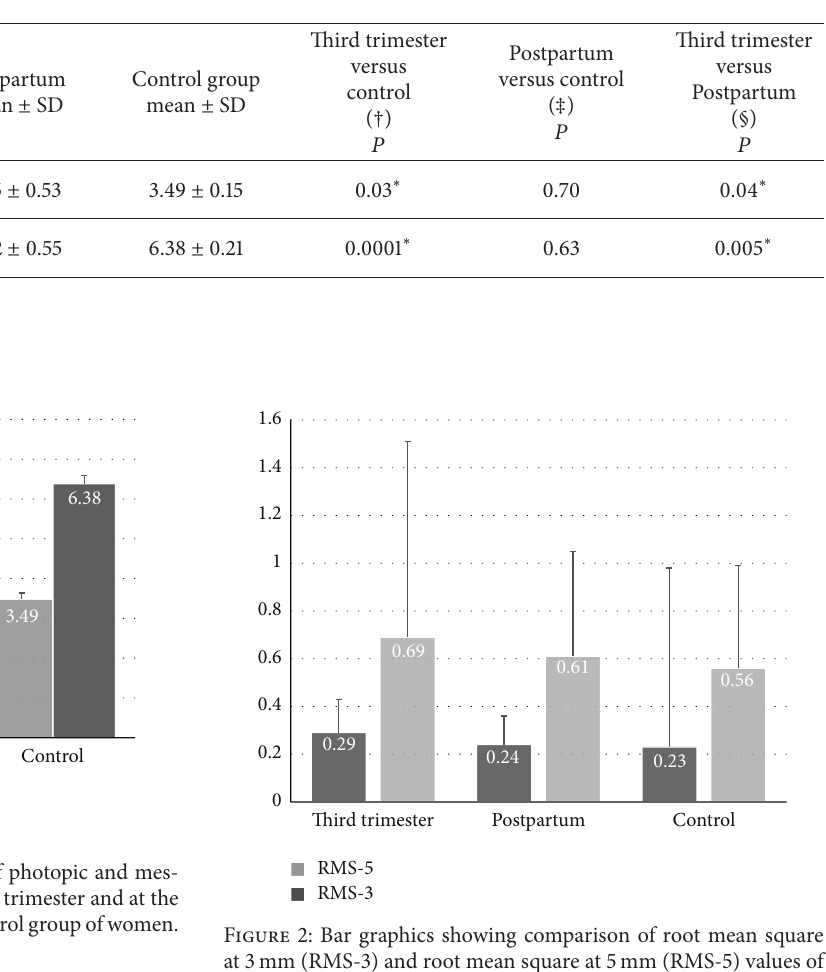
Table 1: Change in photopic and mesopic pupil sizes at the third trimester of pregnancy, at the second postpartum month, and in the control group.